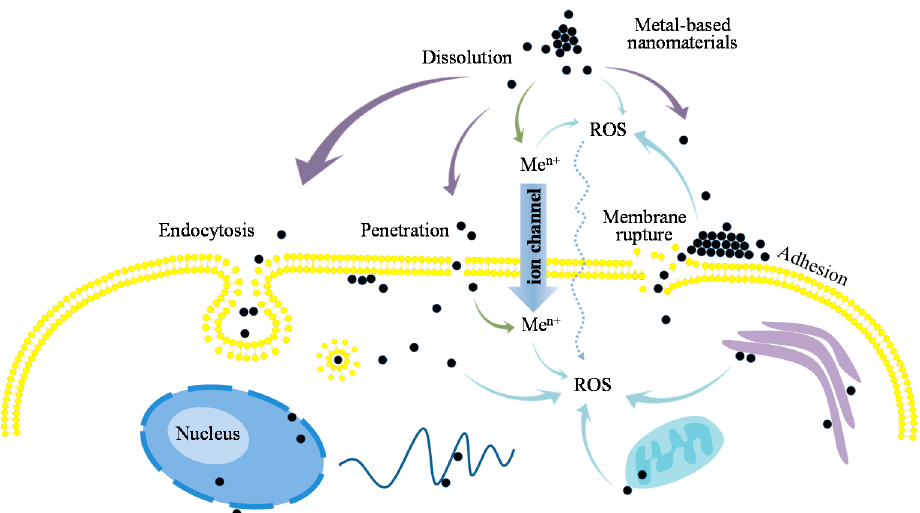
Figure 1. Overview of hypotheses associated with the responses of cellular membrane to the introduction of ENMs. It is assumed that endocytosis, penetration, adhesion of ENMs upon the cellular membrane, and cellular membrane rupture could possibly occur. Cellular membrane rupture is also considered to lead to the internalization of ENMs via the damage sites. Scenario of relevant ion release from ENMs, generation of reactive oxygen species (ROS), and ENMs-contacted interactions are also depicted.